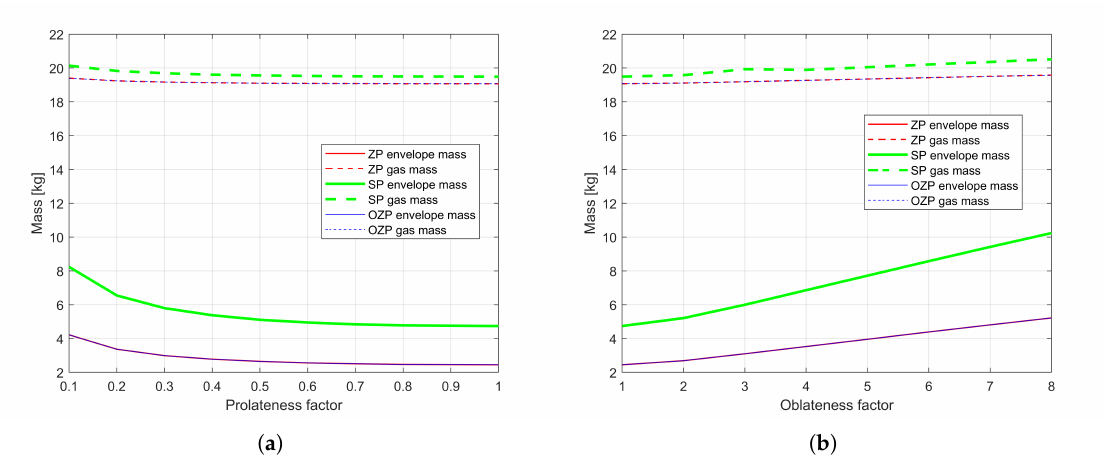
Figure 17. Mass variation of different balloon types at varying fineness ratios on Titan ( a ) airship and prolate ( b ) oblate. Note that the lines for ZP gas mass and OZP gas mass are superimposed, as well as the lines for ZP envelope mass and OZP envelope